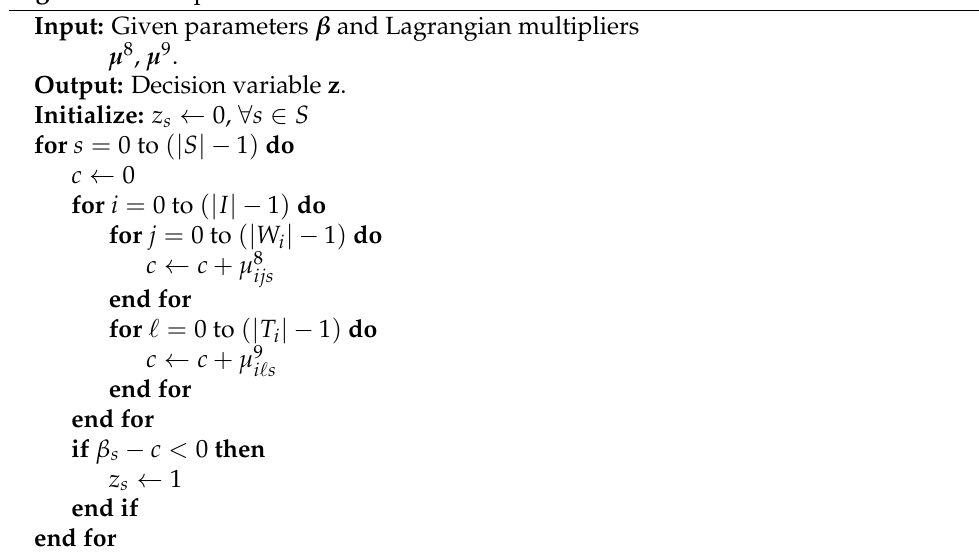
Algorithm 5 Subproblem